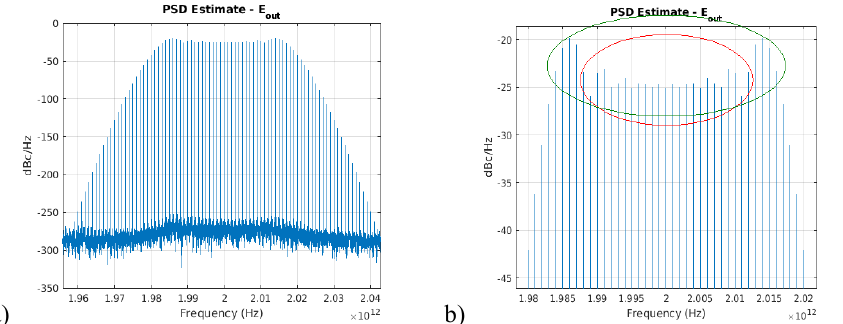
Fig. 3. Spectral density of the modulator output field for 1 GHz modulating frequency: full view (a) and zoom of the central lines (b). Modulation indices in the arms are 15 and 16.5. The red ellipse represents the center lines with amplitude inequality less than 3 dB (25 modes), and the green ellipse represents modes with inequality less than 6 dB (33